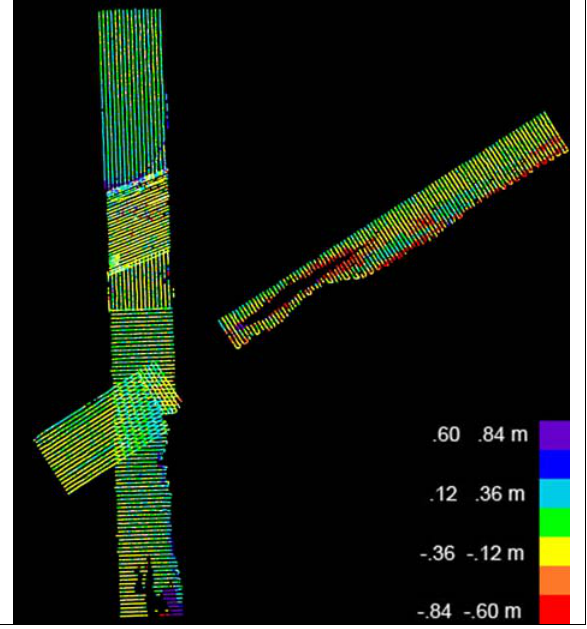
Figure 9: discrepancies between bathymetric LiDAR and ultra sound